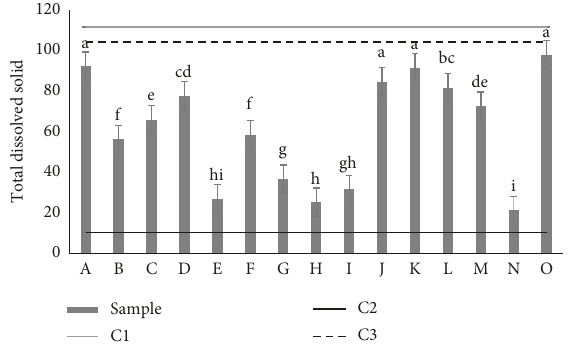
Figure 3: Total dissolved solid for 15 samples of treated water. A-B: Sg. Ramal ; C-E: Section 8, Bandar Baru Bangi ; F-I: Section 16, Bandar Baru Bangi ; J, K, and O Section 3, Bandar Baru Bangi ; L-N: Section 15, Bandar Baru Bangi . C1: household mineral water (Cuckoo); C2: distilled water; C3: commercial mineral water bottle.